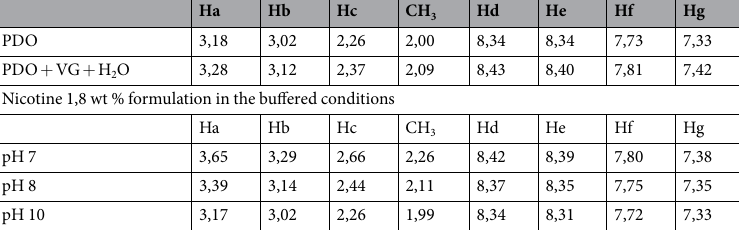
Table 2. Chemical shifts of nicotine in e-liquids measured in D 2 O.